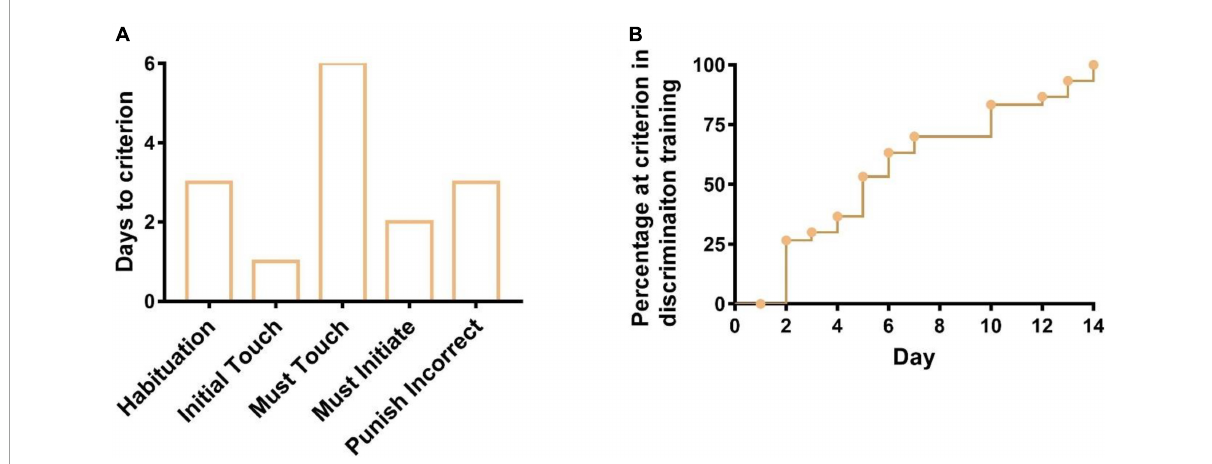
FIGURE2 Days to meet the criterion for six training stages during the pairwise discrimination task. (A) Days to meet the criterion from stage 1 to stage 5 and (B) days to meet the criterion in stage 6 (discrimination